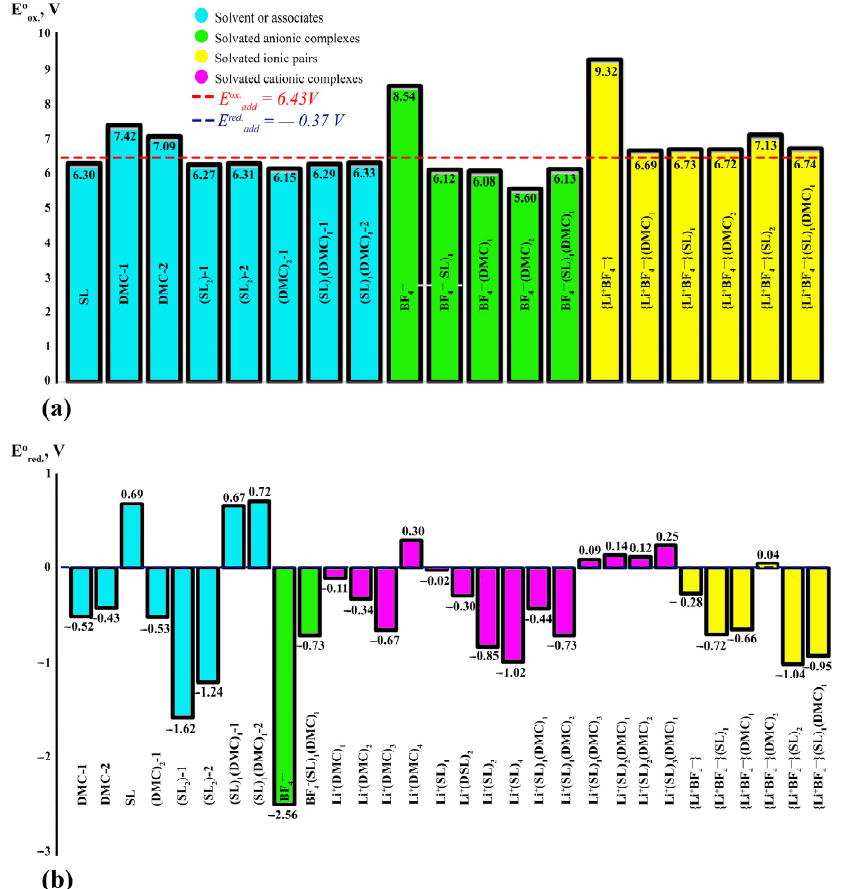
Figure 10 . Oxidation ( a ) and redox ( b ) potentials of all possible complexes of 1 m LiBF 4 (SL/DMC) .